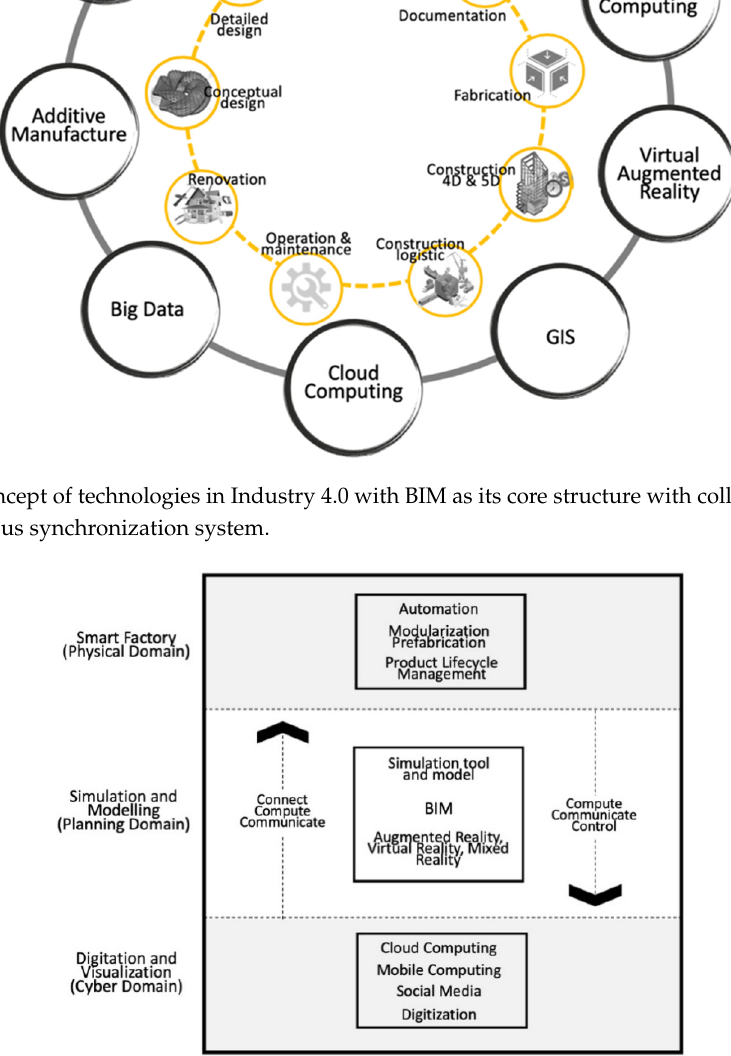
Figure 8. The relationships in the cyber-planning-physical system with BIM as its core. Adapted from previous studies [32,59,64].